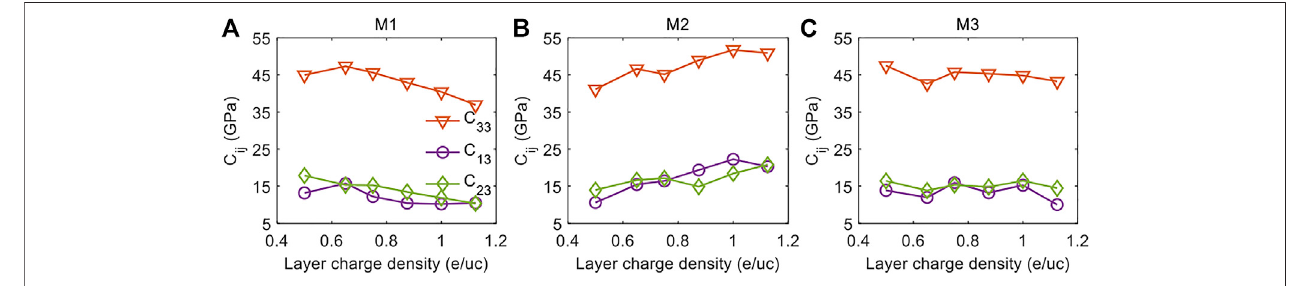
FIGURE 5 | The out-of-plane compressional elastic constants C 33 , C 13 , and C 23 as a function of layer charge density for the (A) M1 Model, (B) M2 Model and (C) M3 Model.